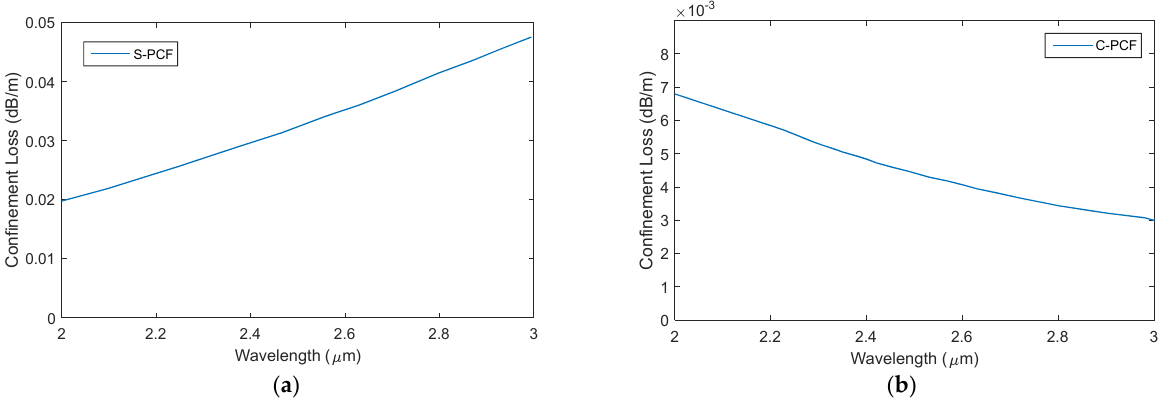
Figure 3. Confinement losses of ( a ) the designed silicon PCF for 𝛬 (cid:3404) 0.75 μ m , 𝑑 𝛬(cid:3415) (cid:3404) 0.8 and ( b ) the designed composite PCF for 𝛬 (cid:3404) 2.5 μ m , 𝑑 𝛬(cid:3415) (cid:3404) 0.8 as a function of wavelengths.